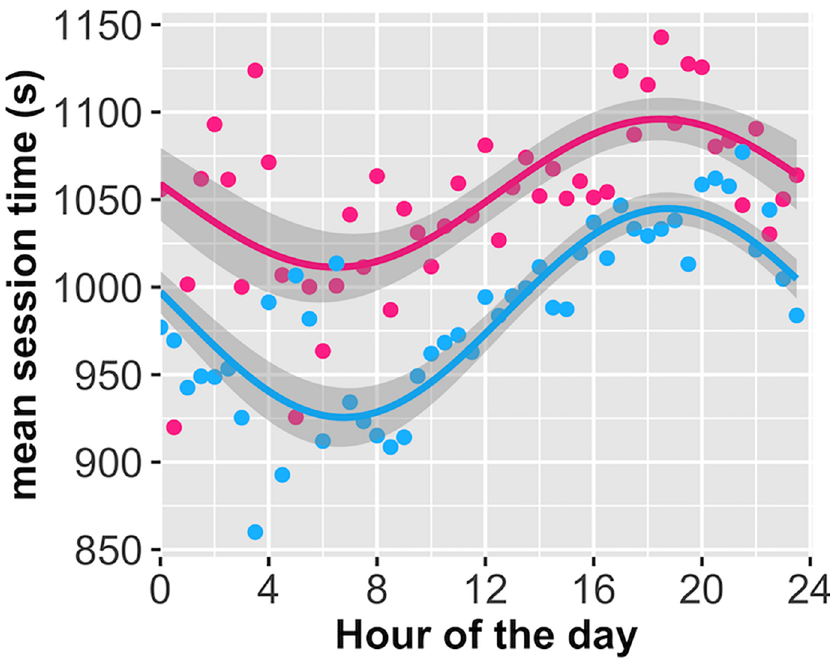
Fig 7. Average session length with 1st harmonic regression line. Red = sample 1 data. Blue = sample 2 adjustingfor users’ time-zone. Points reflect the averagesession length across sessionsfor each 30-minute window.Coloredlines represent regressionline, shadedregions represent the 95% CI of the fixed effect.